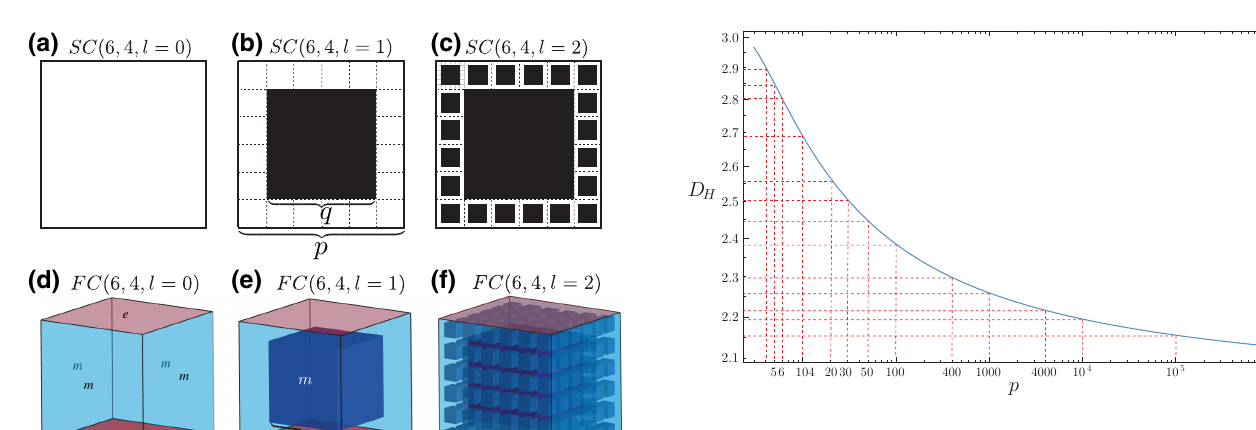
FIG. 22. The Hausdorff dimensions D H of a subfamily of fractal-cube geometries FC ( p , p − 2 )